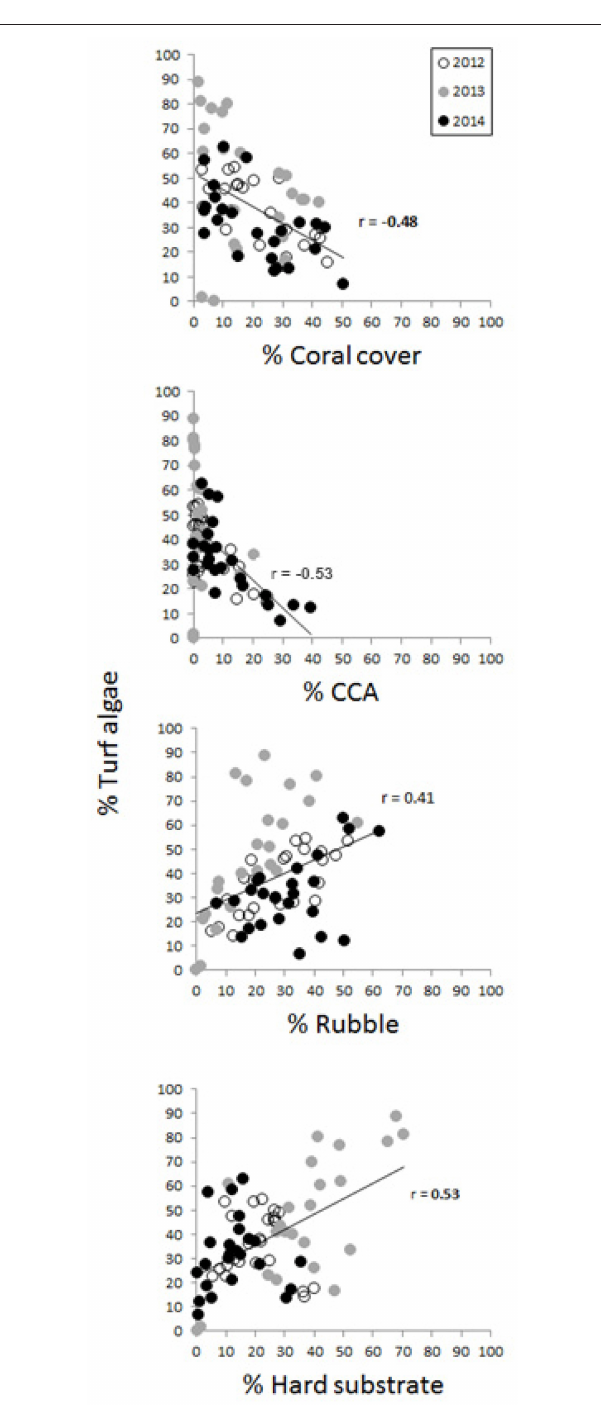
FIGURE 7 | Correlations between turf algae and live coral cover, CCA, rubble and hard substrate. Years are shown in separately by color but pooled for the correlation analyses. All correlation coefficients are significant ( P <